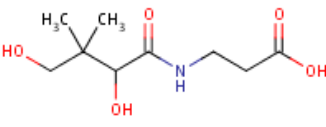
Figure 9. Pantothenic acid structure.